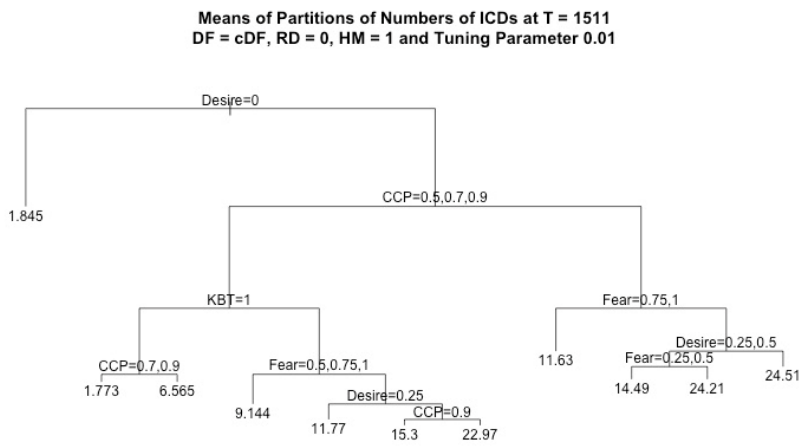
Figure 5. Tree model for means of partition numbers of ICDs at simulation end with parameters RD = 0, HM = 1, and tuning parameter = 0.01, when agents used cDF. For each node, the left branch is conditional on the node being true.